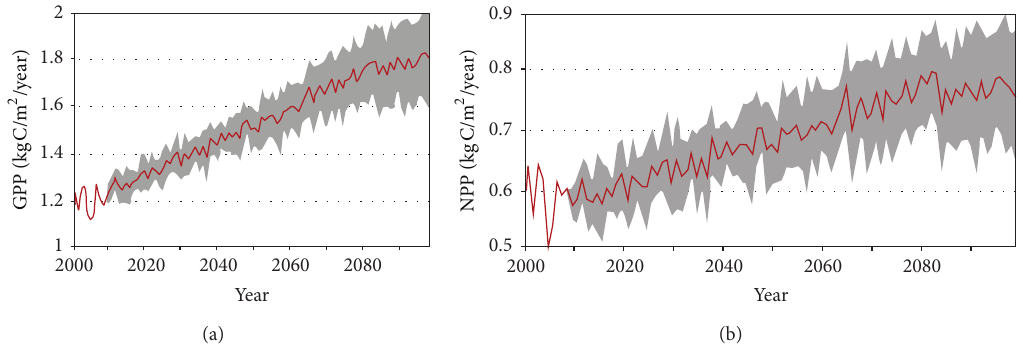
Figure 5: Projection of terrestrial primary production in response to climate change and increasing atmospheric CO 2 from 2000 to the 2090 as simulated by DLEM (a) change in gross primary production and (b) change in net primary production (modified from Song et al. [114]).